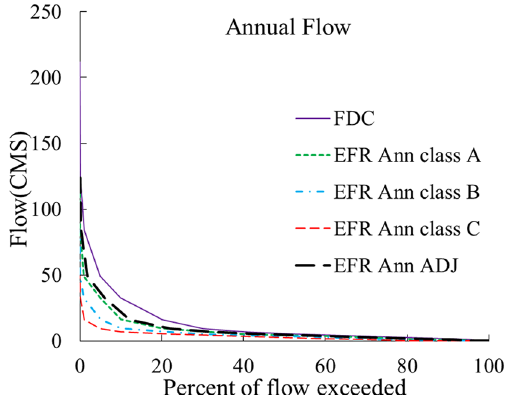
Figure 5. Comparison of annual FDCs for different EMCs with the shifted FDC based on the adjusted EFR of the lake at the Tapik Station, Nazlu